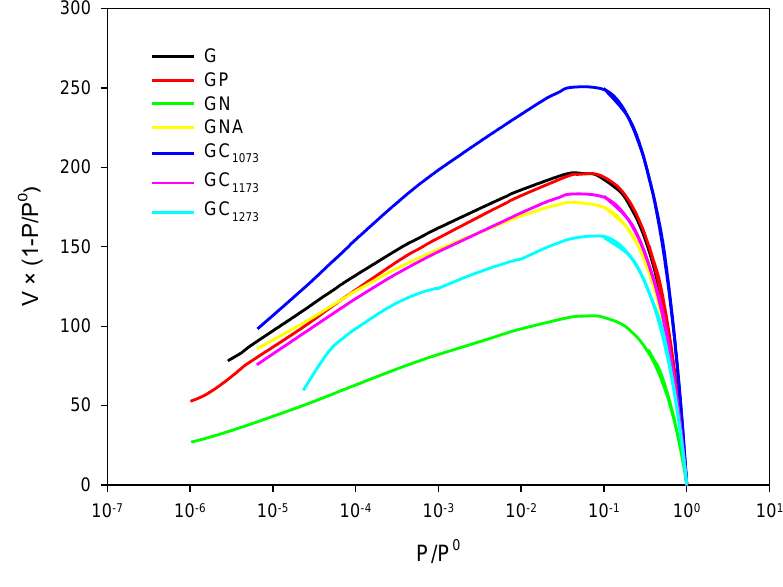
Figure 1. Optimization of the BET range. Table 1. Textural Characterisation of activated carbons obtained from the N2 adsorption isotherm at 77